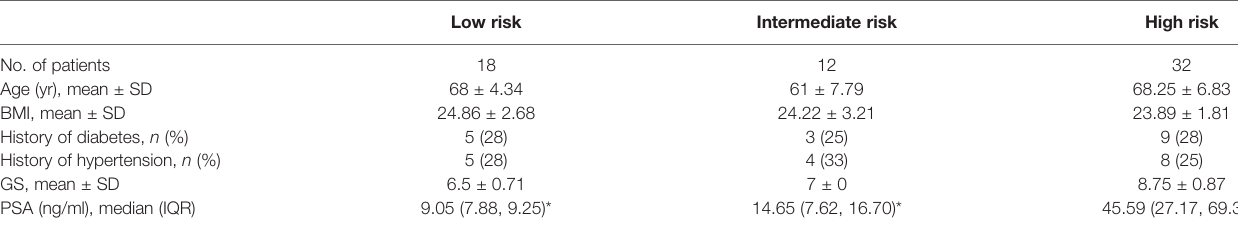
TABLE 1 | Baseline characteristics of enrolled